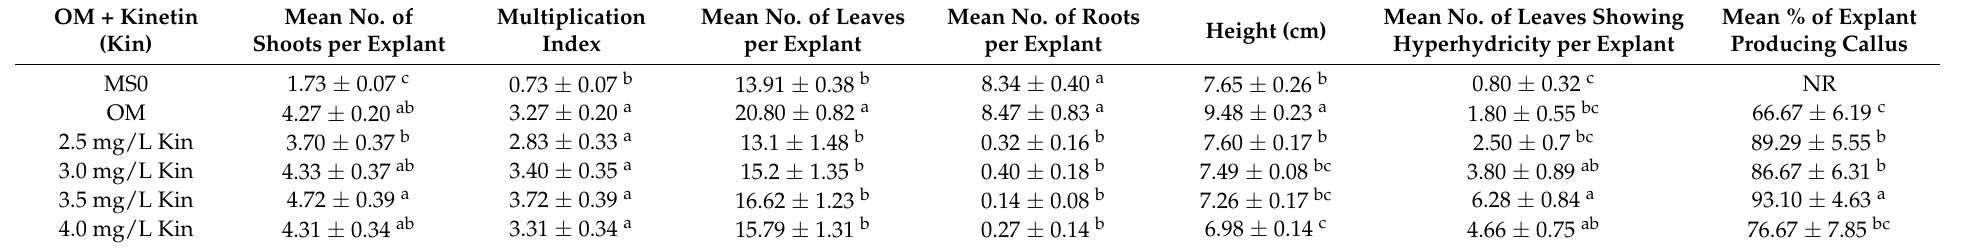
Table 6. Effects of high kinetin levels on mean number of shoots, multiplication index, leaves and roots per explant, mean percentage (%) of explant producing